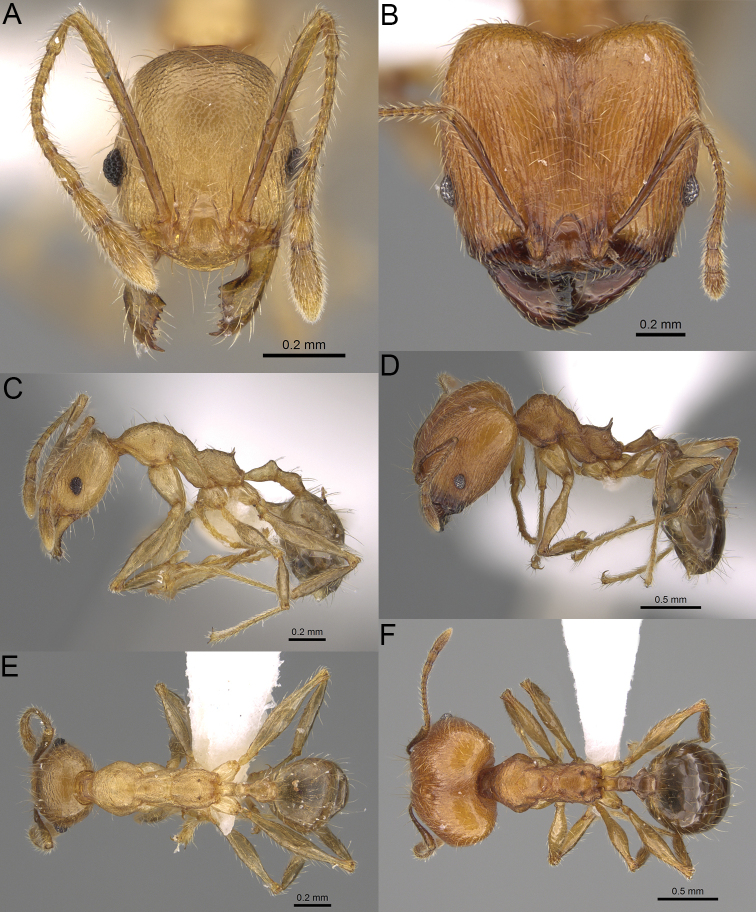
Pheidole
gracilis sp. nov., full-face view (A), profile (C), and dorsal view (E) of paratype minor worker (CASENT0403309) and full-face view (B), profile (D), and dorsal view (F) of holotype major worker (CASENT0403308).